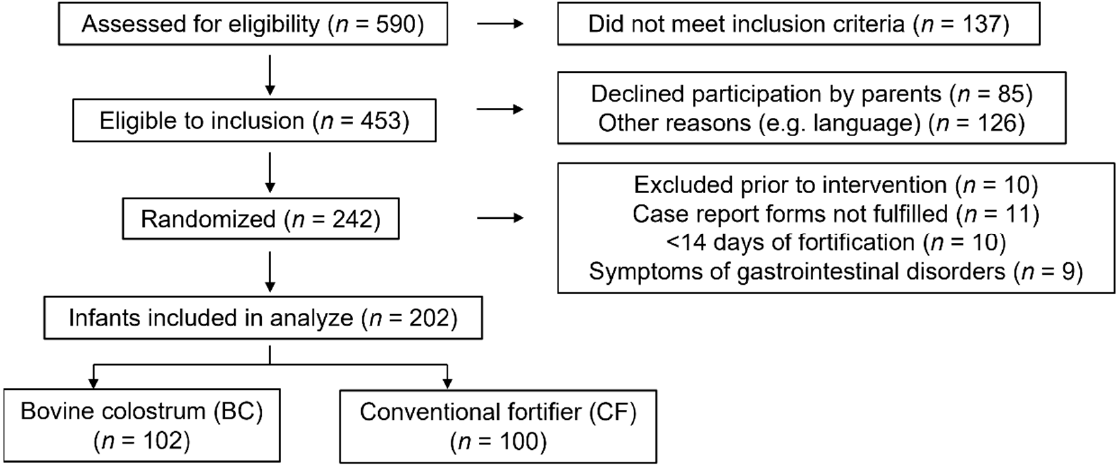
Figure 1. Consort of flow of participants. At baseline, no differences were observed for demographic variables and clinical characteristics, except that BC infants started fortification one day earlier than CF infants ( p < 0.05, Table